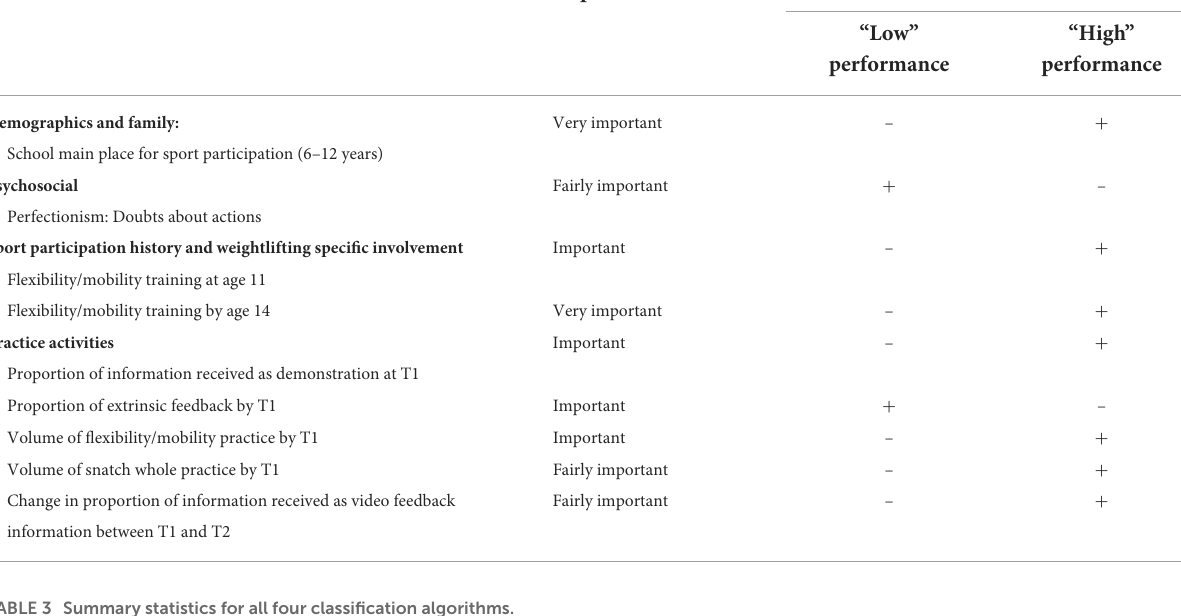
TABLE 2 The list of attributes selected for the summary model, along with their rating of importance and direction of influence on weightlifting performance. Attribute